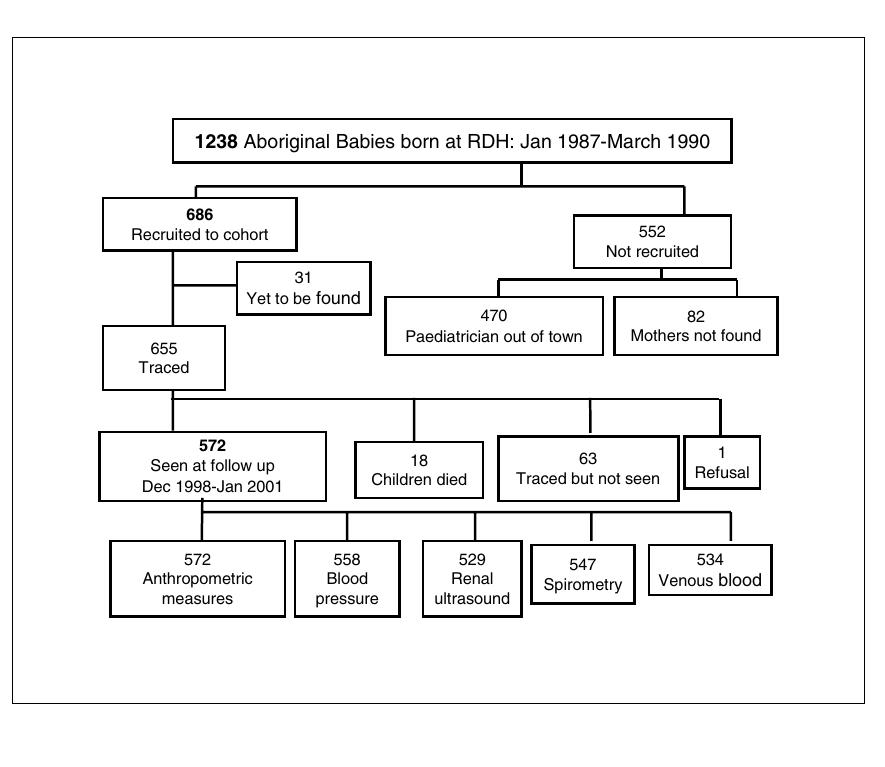
Flow chart of Aboriginal Birth Cohort